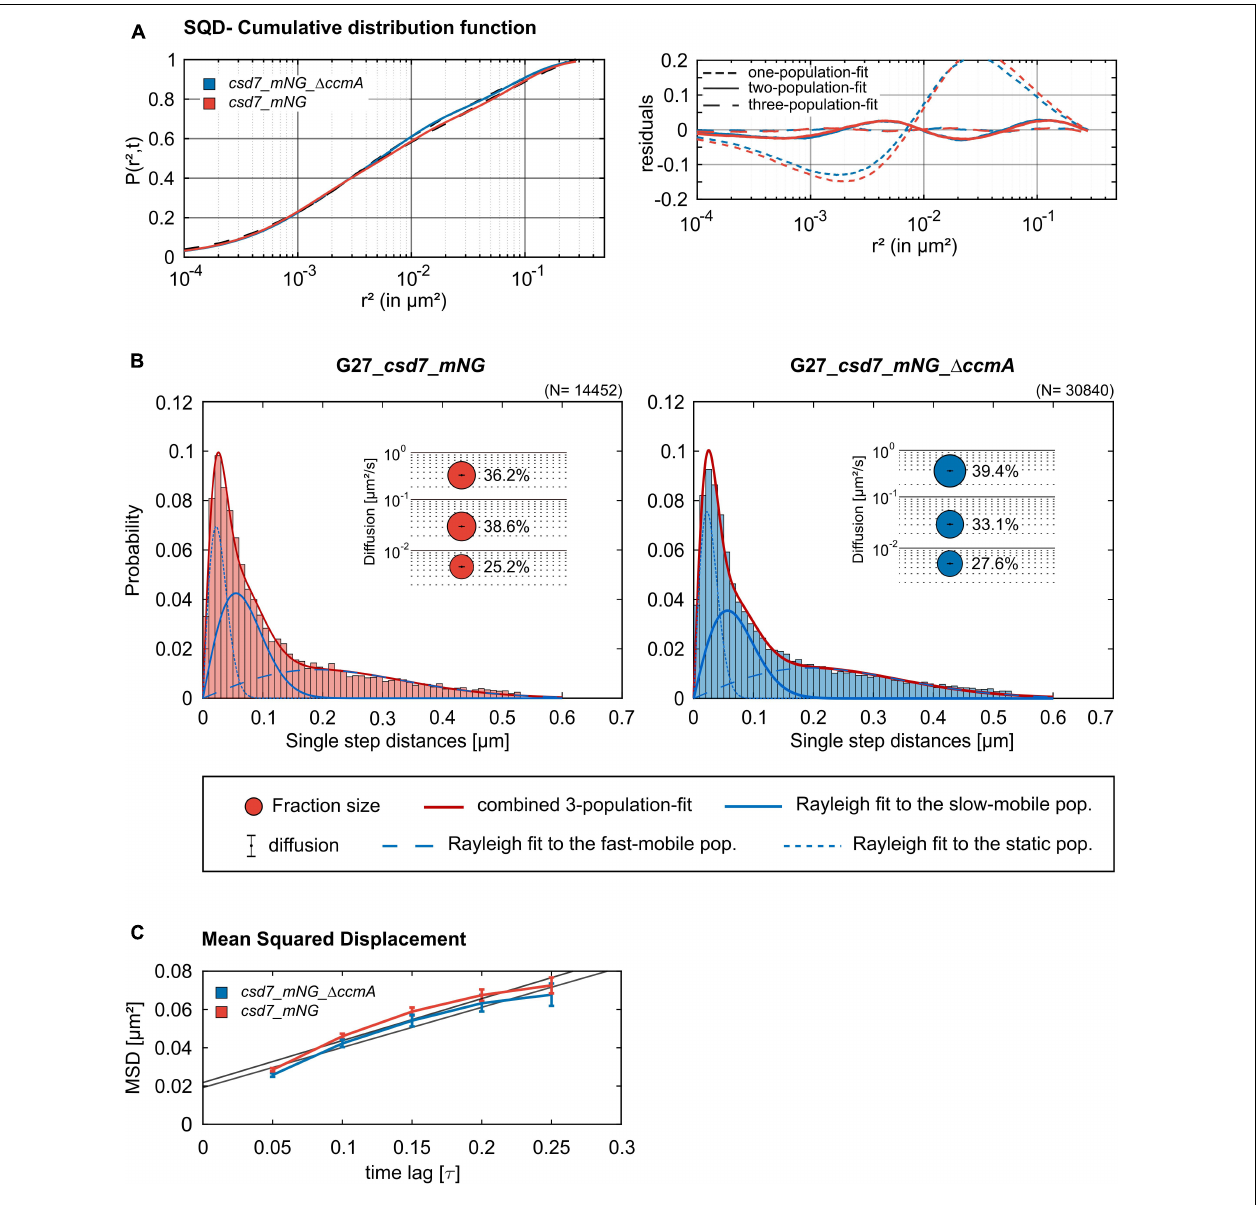
FIGURE 7 | Single-molecule tracking analysis of the G27_ csd7 _ mNG strain and the bactofilin-knockout strain. Data represent a biological triplicate with 95 cells, 2,056 tracks for G27_ csd7 _ mNG and 110 cells, 4,326 Tracks for G27_ csd7 _ mNG_ (cid:49) ccmA . The movies were acquired with an exposure time of 50 ms per frame. (A) The cumulative distribution function (left panel) indicates the best fit for three populations. Residual analysis (right panel) is a quality indicator of the SQD analysis: the difference between the measured data (colored line) and modeled data (“zero” line) confirms three population assumptions. According to the data, we detected marginal effects of the bactofilin deletion in G27. With diffusion coefficients barely changing, a small fraction of the slow-mobile population shifts to the mobile and static populations. (B) Squared displacement analysis (SQD) of Csd7_mNG in G27 wt and CcmA deletion background. Diagrams display the probability for each detected jump distance. Bubble plots show the estimated population and diffusion coefficients as identified by non-simultaneous SQD curve fitting. N, number of steps. (C) Mean-squared displacement curves show a general diffusion regardless of subdiffusion. According to the MSD, the deletion of CcmA did not affect the overall diffusion of